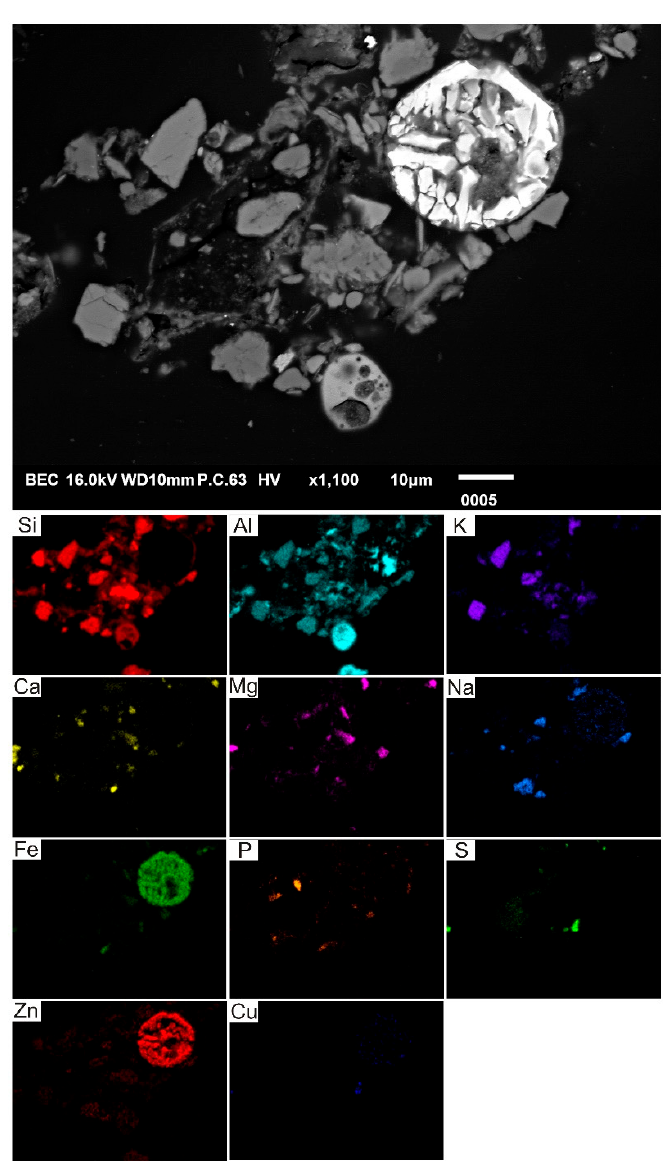
Figure 7. Element distribution map (scanning electron microscopy–energy-dispersive X-ray spectroscopy, SEM-EDX) of soil taken from sampling point G1 in August 2018 in the vicinity of Olmaliq city.